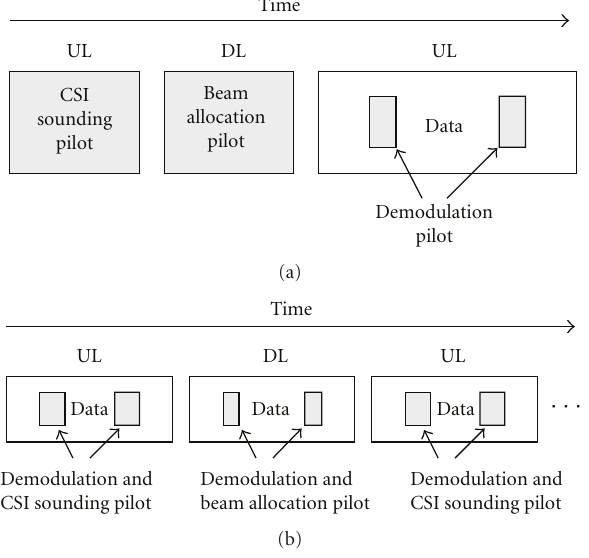
Figure 3: Simplified TDD frame and pilot structure needed for (a) UL beamforming, (b) UL/DL beamforming.